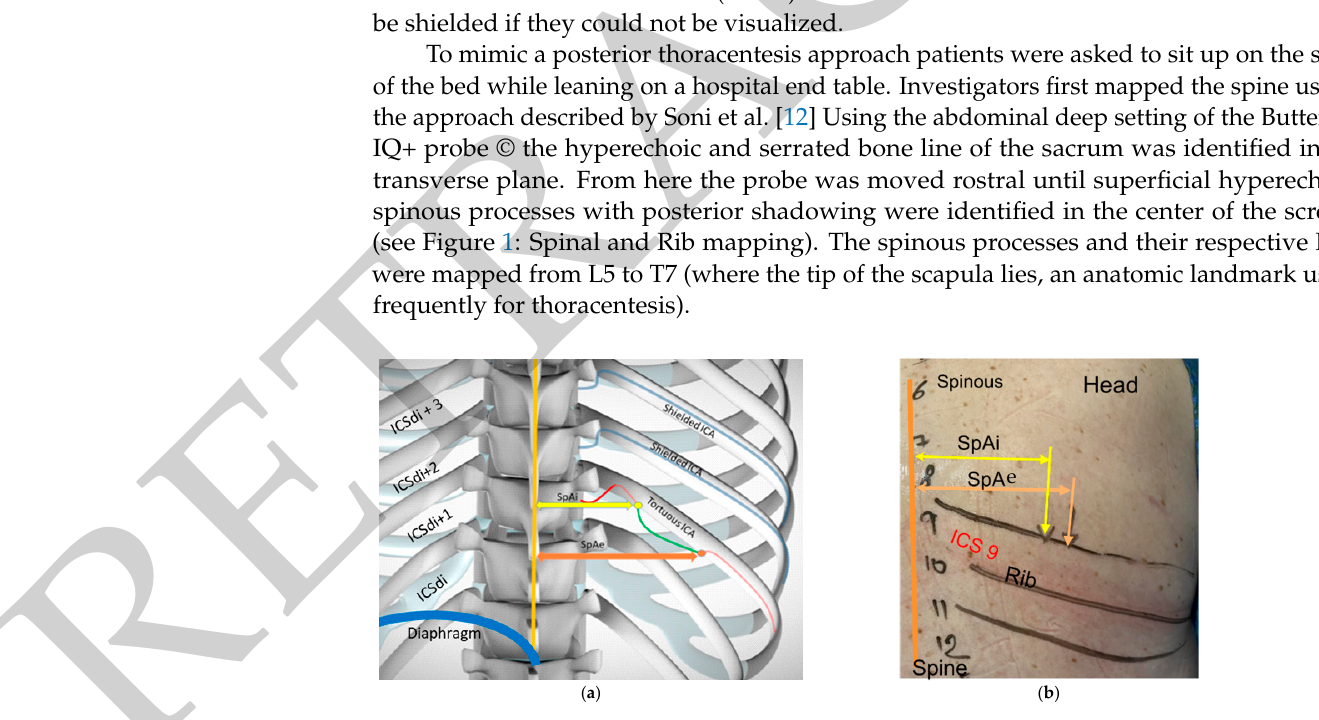
Figure 1. Spinal and Rib mapping. ( a ) Schematic representation, ( b ) Measurements on patient’s back. Legend: Blue line depicts the diaphragm. ICSdi: refers to the ICS at mid-axillary line where the diaphragm was seen ICSdi + 1 to +3 refers to ICS level above the ICSdi and represent the scanned areas. Measurements were done using a paper ruler in cm, SpAi: (yellow arrow), distance between spinal column (Orange line) and initial entry of Intercostal artery into the intercostal space, SpAe: (Orange Arrow) distance between spinal column and exit of intercostal artery from the intercostal space, Green segment of intercostal artery represents its unshielded length (UnL), and is equal to